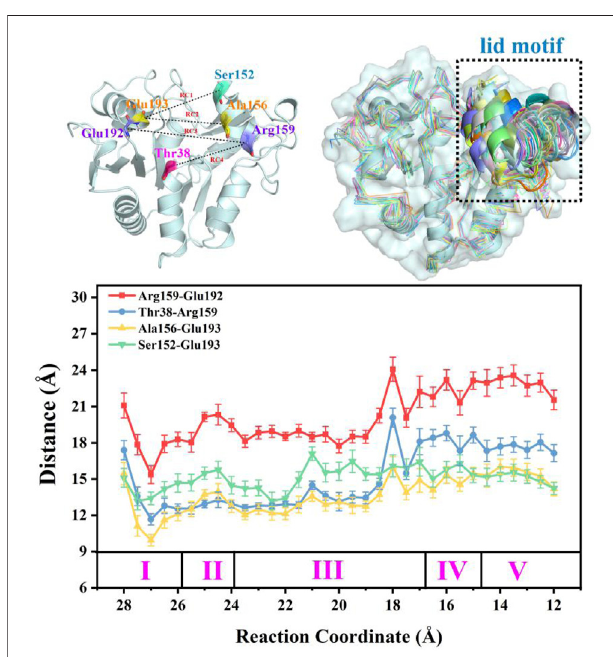
FIGURE 10 | Overlap of the enzyme-substrate complex in alkaline solution at different stages and distances between key residues that re fl ect conformation changes to the lid motif during the substrate delivery